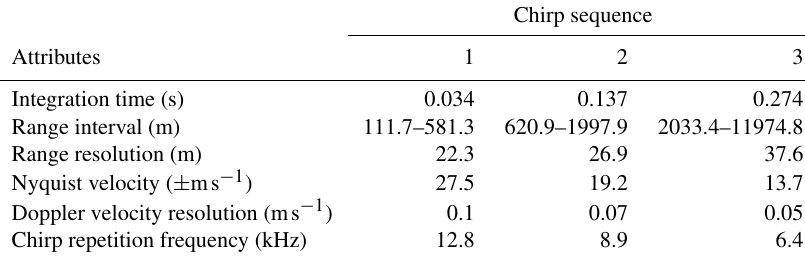
Table 3. Configuration parameters used by the dual-band radar CLARA for each chirp sequence.